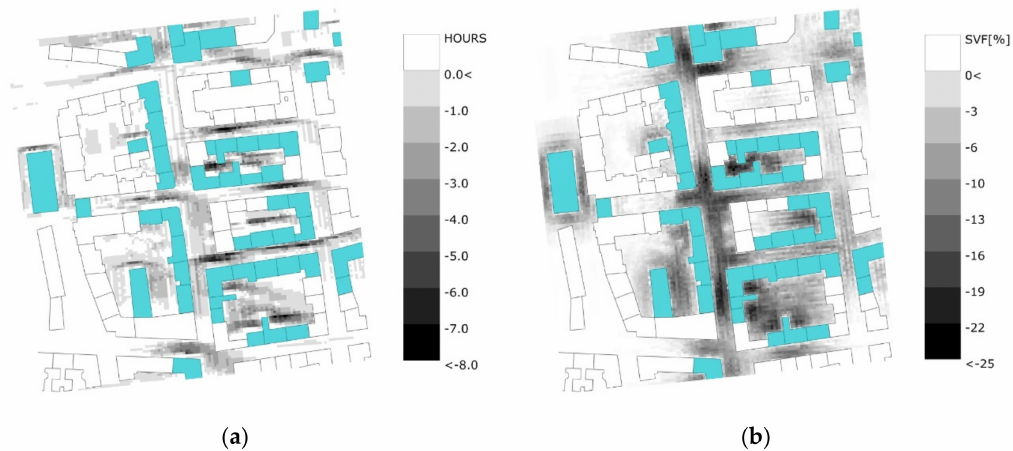
Figure 6. Di ff erence maps: ( a ) sunlight hours; ( b ) sky view factor at ground level (densification marked by cyan rooftops).